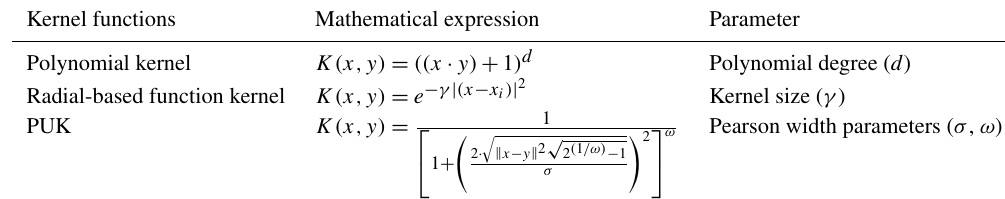
Table 3. Basic kernel functions used in the study with parameters that needed to be determined. Kernel functions